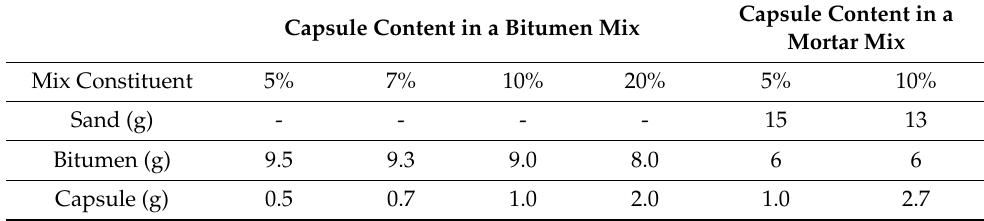
Figure 3. Bitumen ITS test specimen: ( a ) Struers FixiForm 30 mm diameter, ( b ) specimen prepared in the mould, ( c ) test specimen, and ( d ) ITS test set up. Table 1. Bitumen and mortar ITS test specimen mix.